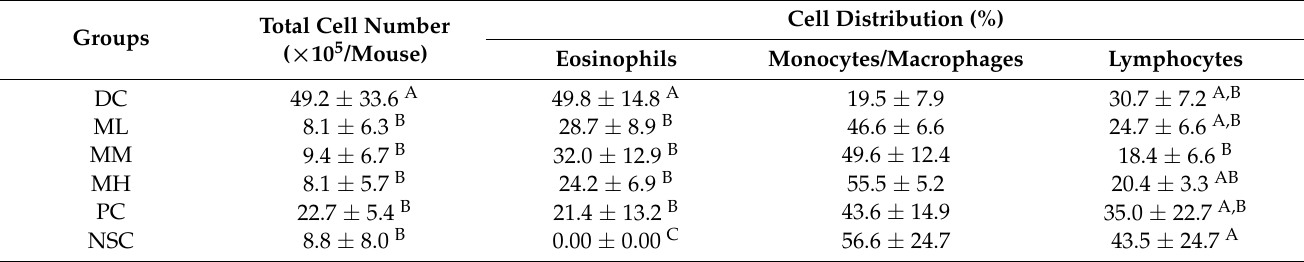
Table 1. Effects of menthone inhalation with different doses on total cell numbers and differential cell distributions in the BALF of OVA/Al-sensitized and challenged BALB/c asthmatic